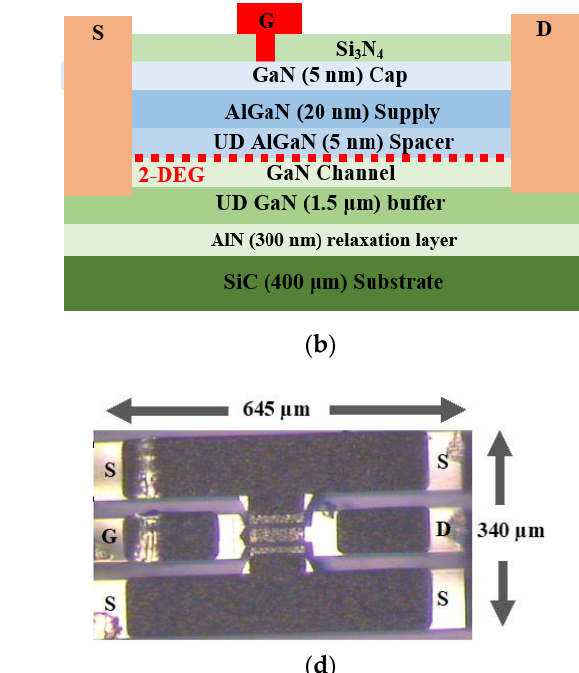
Figure 3. DC output characteristics of the studied GaN HEMT at different T a . At the selected bias voltages (see Figure 4), the dimensionless relative sensitivity of I ds with respect to T a is calculated by normalizing the relative change in I ds to the relative change in T a : 𝑅𝑆𝐼 𝑑𝑠 = 𝛥𝐼 𝑑𝑠 𝐼 𝑑𝑠0 𝑇 𝑎0 𝛥𝑇 𝑎 = (𝐼 𝑑𝑠 − 𝐼 𝑑𝑠0 ) 𝐼 𝑑𝑠0 𝑇 𝑎0 (𝑇 𝑎 − 𝑇 𝑎0 ) (1) where I ds 0 is the value of I ds at the reference temperature ( T a0 ) of 25 °C. As can be observed in Figure 4, RSI d s is negative for both devices, as a consequence of the fact that an increase in T a leads to a decrease in I ds , and is of greater magnitude for the GaN technology, as a consequence of the much higher P diss leading to a higher channel temperature (i.e., T ch = T a + R th P diss where R th is the thermal resistance).